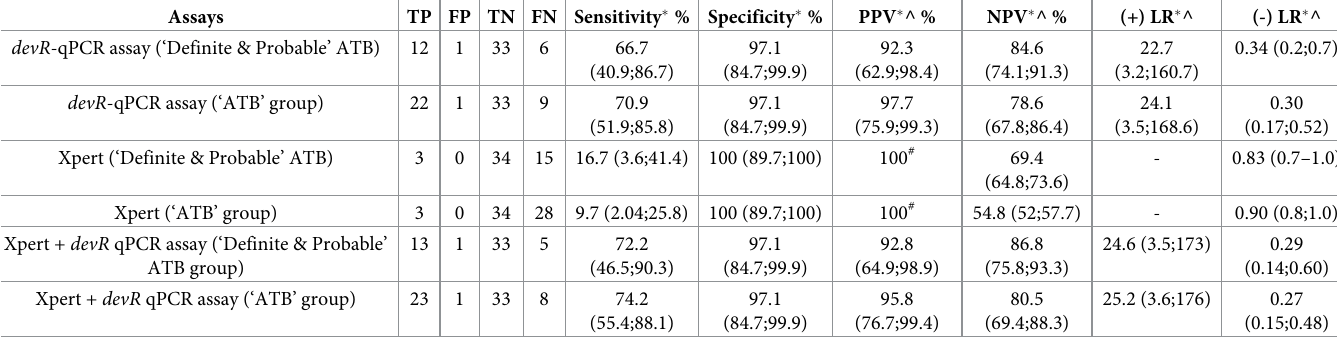
� value in brackets indicates 95% confidence interval.